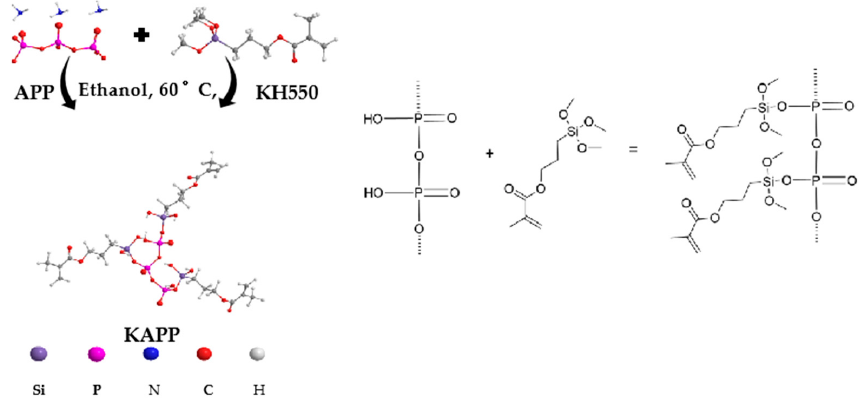
Figure 9. KH550 modified APP reaction mechanism diagram. Table 7. Comparison of APP and KAPP surface elements.